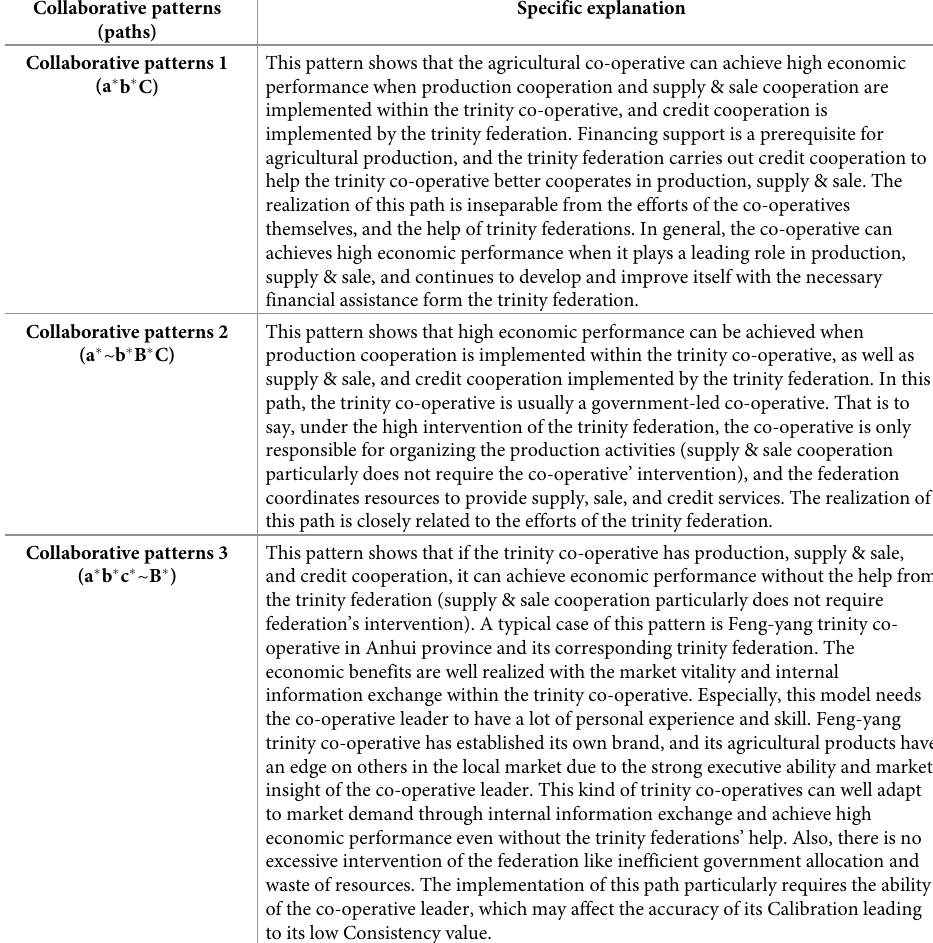
Table 6. The specific analysis of collaborative patterns to “high economic performance”.